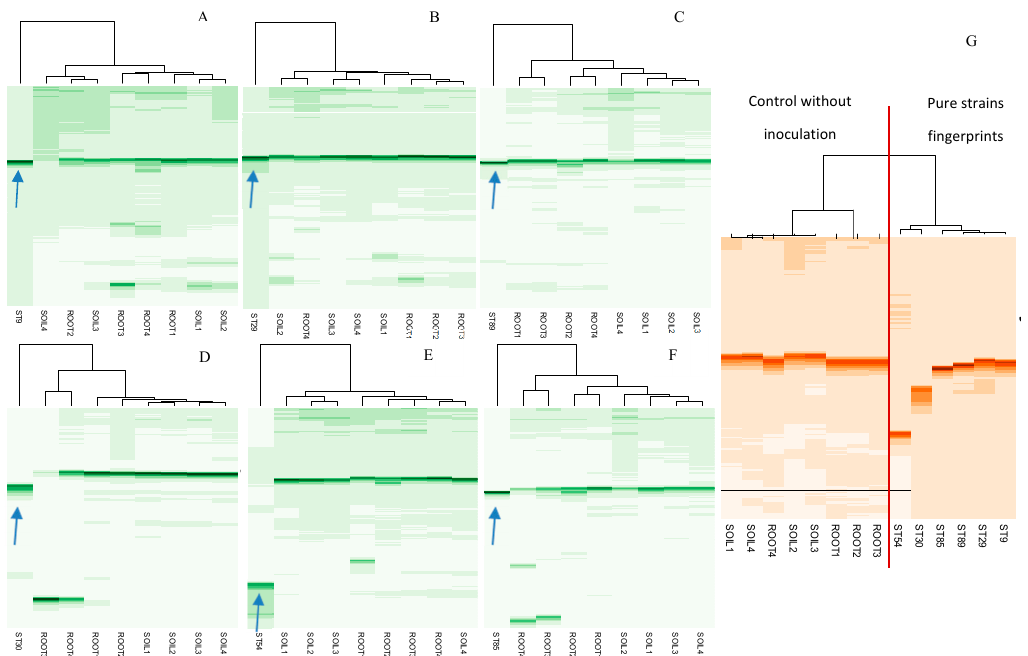
Figure 4. Heatmaps of strain recolonization in rhizosphere (soil) and root endosphere (root) of ( A ) B. paramycoides ST9 ( B ) B. wiedmannii ST29 ( C ) B. proteolyticus ST89 ( D ) Brevibacterium frigoritolerans ST30 ( E ) Cellulosimicrobiumcellulans ST54 ( F ) Methylobacterium ST85. Blue arrows indicate the pure